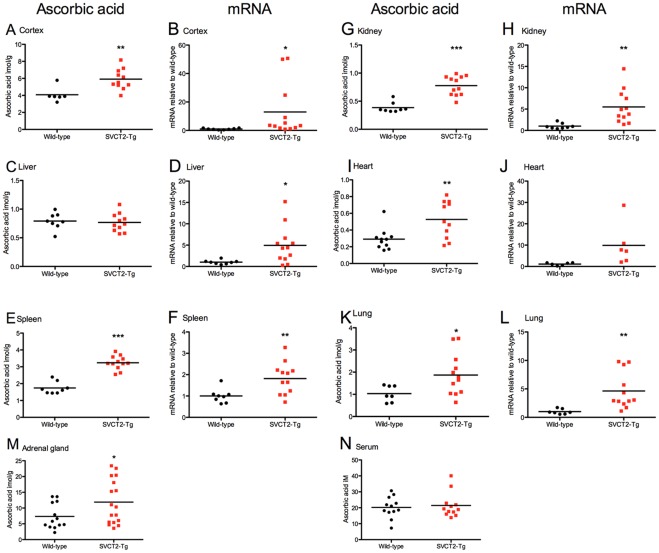
Ascorbic acid and mRNA level in SVCT2-Tg mice.SVCT2-Tg had higher ASC levels in all organs measured except liver, nor did serum ASC vary between groups. (A) cortex, (C) liver, (E) spleen, (G) kidney, (I) heart, (K) lung, (M) adrenal gland, and (N) serum. mRNA signal was increased in all organs measured, although this difference was not significant in heart. (B) cortex, (D) liver, (F) spleen, (H) kidney, (J) heart, (L) lung, (M) adrenal gland, and (N) serum. *, **, *** p<0.05, 0.01, 0.001 compared to wild-type controls.